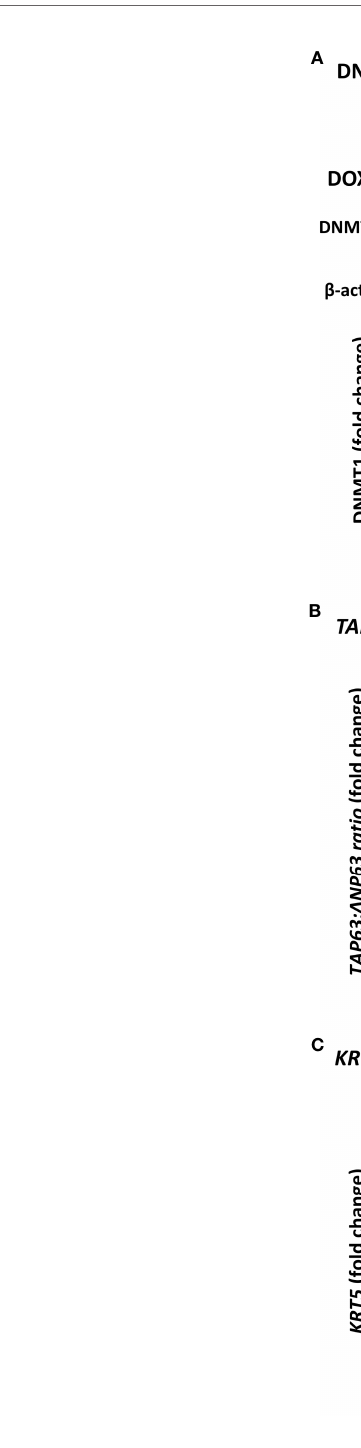
FIGURE 5 | DNMT1 depletion alters TP63 isoform mRNA levels and decreases KRT5 mRNA levels. (A) Representative Western blots of DNMT1 in two independent clones of HaCaT and FaDu DNMT1 -shRNA cells cultured for four days in the absence ( – ) or presence (+) of 2 µg/ml doxycycline (DOX). b -actin is shown as loading control. Densitometric quantitation of DNMT1 normalized to b -actin is shown below for each clone. (B) Relative changes in the ratio of TAP63 to D NP63 mRNA levels without induction (CTR) or after six days of 2 µg/ml doxycycline (DOX). Data were normalized to ACTB mRNA for each clone in each cell line and are shown as the average change for the two independent clones for each cell line. (C) KRT5 mRNA levels in response to DNMT1 -shRNA induction. Plots show fold change ± SEM compared to non-induced cells. n = 3 to 5 biological replicates; *p < 0.05; **p <